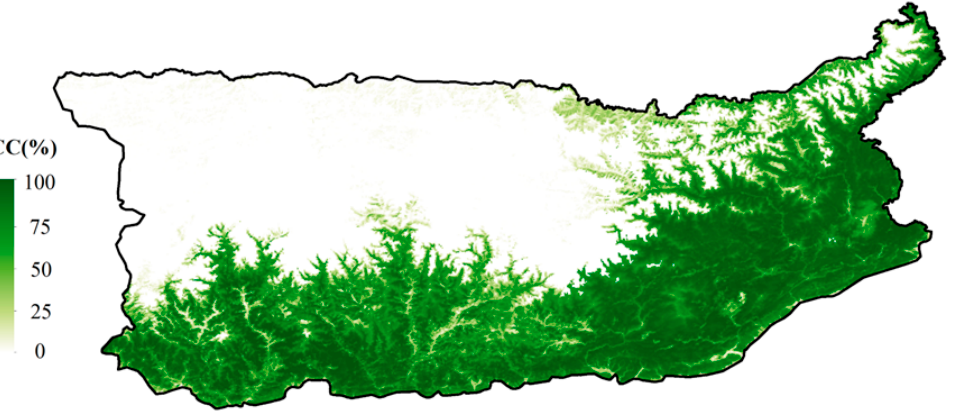
Figure 5. Spatial distribution of the mean TCC between 1990 and 2020 in the Eastern Himalayas. The areas associated with different tree-canopy cover show a bimodal pattern with peaks at approximately 0% to 5% and 85% to 96% (Figure 6a). Tree canopy was found primarily above sea level to below 5000 m asl, with the tree-canopy cover reaching the densest values in elevations between 500 m asl and 3000 m asl and becoming nearly absent in areas above 5000 m asl (Figure 6b). Tree-canopy cover also increases gradually from west to east with increasing longitude; the densest distribution is found between 93 ◦ E and 95.4 ◦ E (Figure 6c). South of latitude 29.2 ◦ N, tree-canopy cover in the Eastern Himalayas decreases, with the densest distribution between 26.6 ◦ N and 27.6 ◦ N. In contrast, tree canopy increases in density as latitude increases above 29.2 ◦ N (Figure 6d).